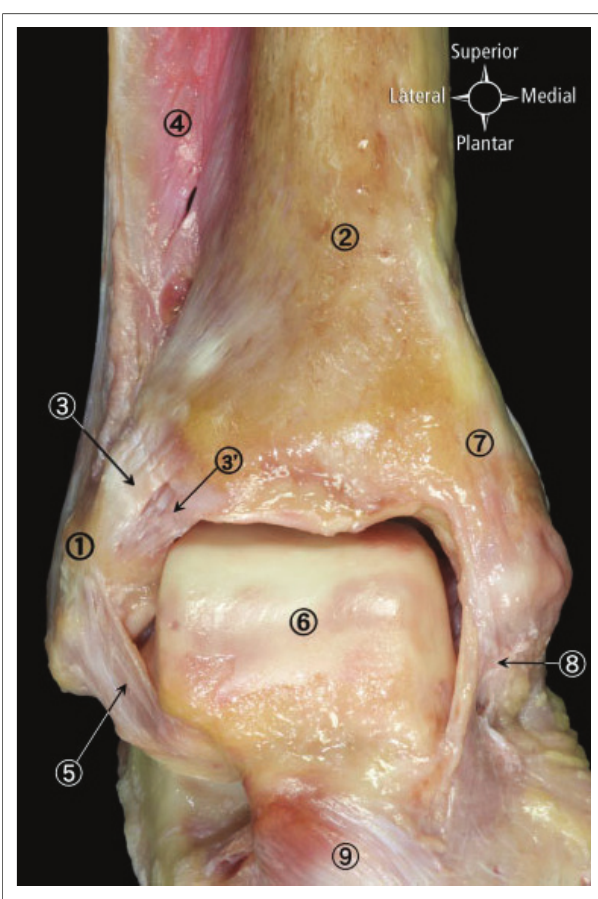
FIGURE 1: Anatomical dissection of the lateral ankle ligaments: (1) Lateral malleolus; (2) Tibia; (3) Anterior tibiofibular ligament; (4) Interosseous membrane; (5) Calcaneofibular ligament; (6) Anterior articular surface of the talus; (7) Medial malleolus; (8) Medial collateral ligament; (9) Dorsal talonavicular